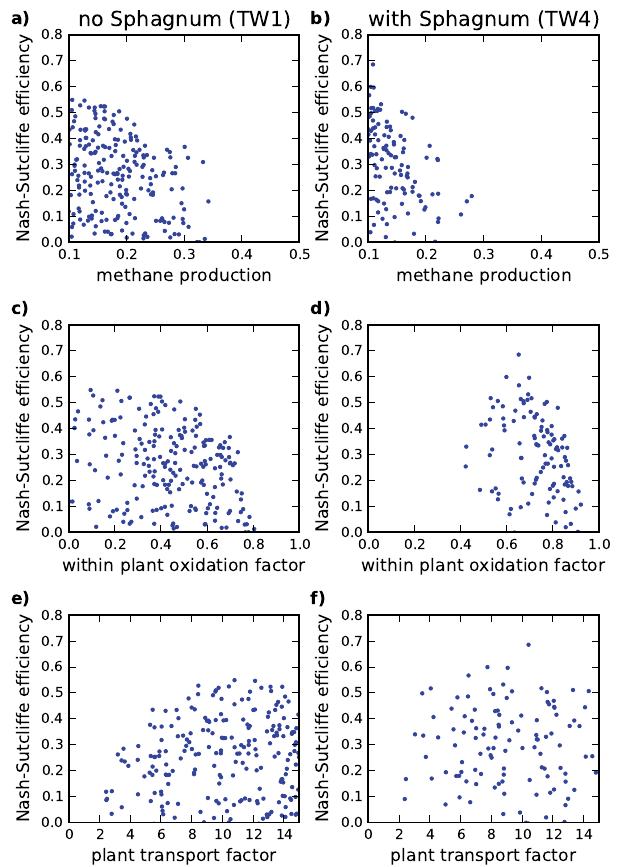
Fig. 5. GLUE analysis of model parameters for both vegetation types, showing Nash-Sutcliffe efficiency. On the left side ( a , c and e ) the results for the vegetation type without Sphagnum , TW1, are shown, while the results for the vegetation type with Sphagnum , TW4, are shown on the right hand side ( b , d and f ). The top row ( a and b ) shows values for methane production, R 0 . The middle row ( c and d ) shows values for within plant oxidation of methane, f ox , and the bottom row ( e and f ) shows values for plant transport factor, V transp